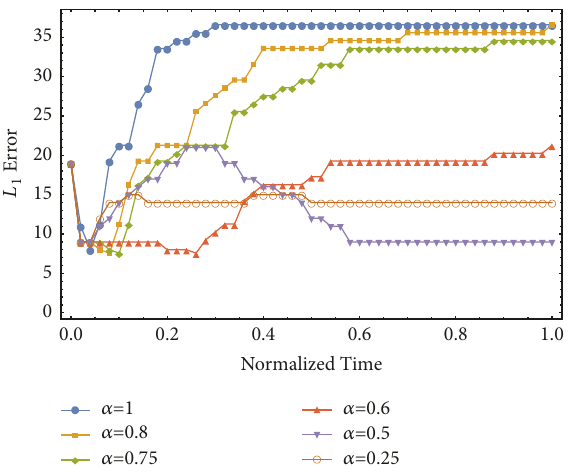
Figure 8: Plot 𝐿 1 errors against number of iterations for various values of 𝛼